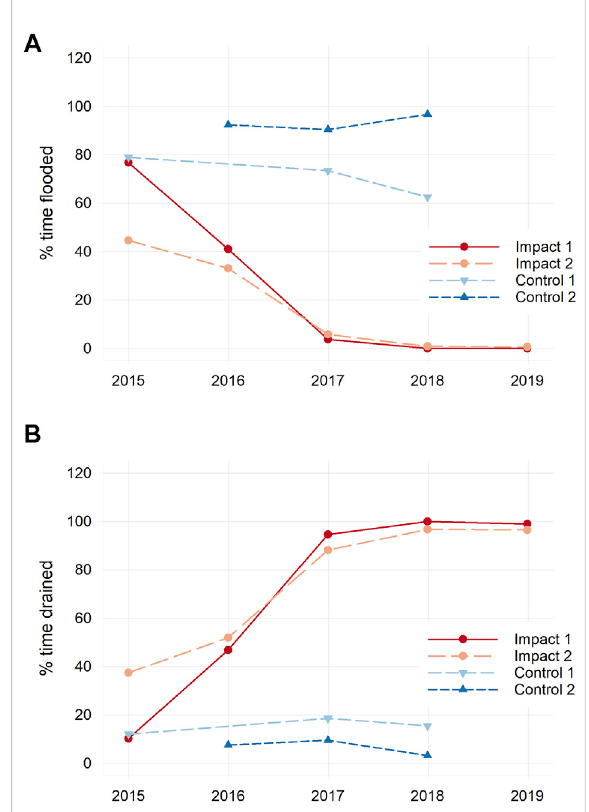
FIGURE 5 Percent of time each year that the marsh surface was inundated with tidal water (A) and drained (i.e., water levels less than 5 cm below the surface of the marsh; (B) in the impact and control marshes. Two loggers were deployed simultaneously in each marsh for approximately 1 month in summer each year. Sediment placement occurred between 2016 and